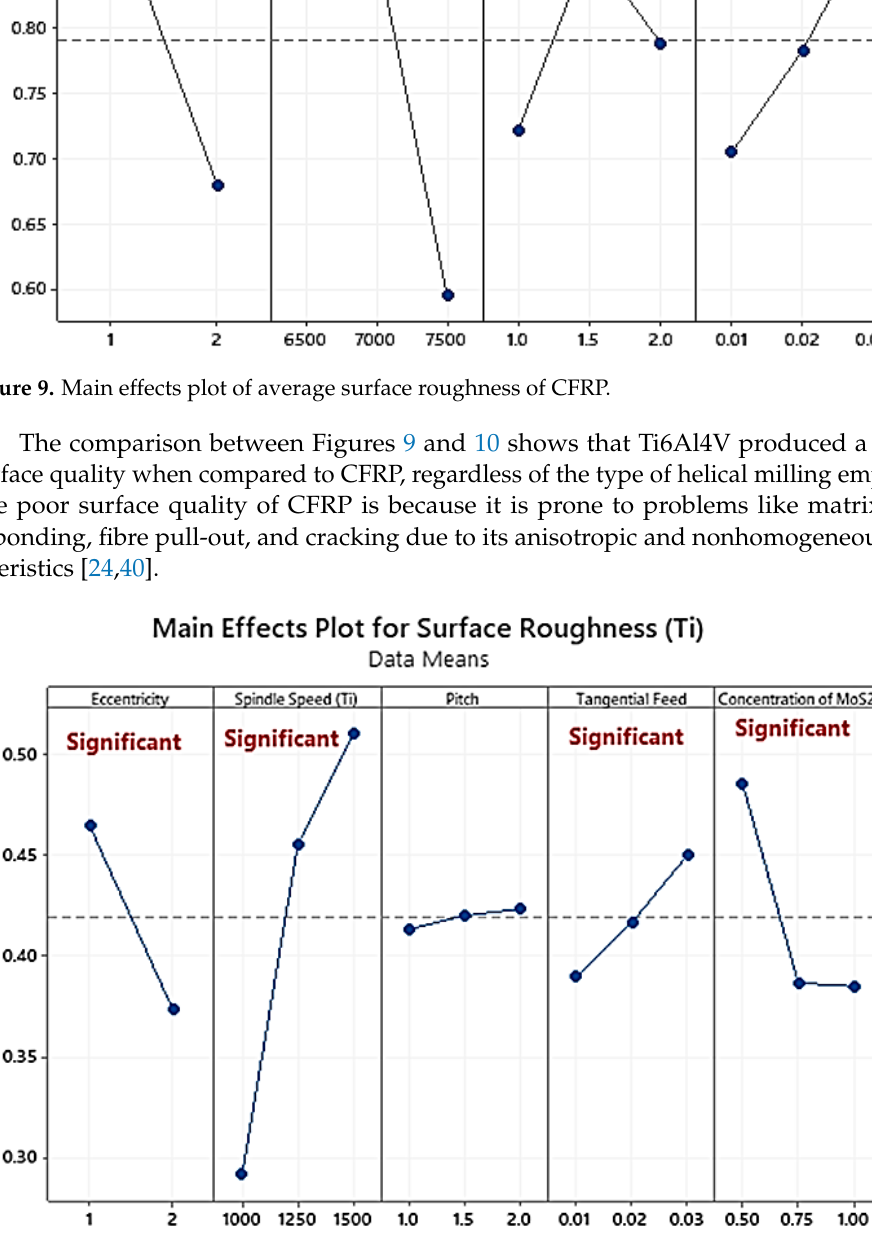
Figure 10. Main effects plot of average surface roughness of Ti6Al4V.